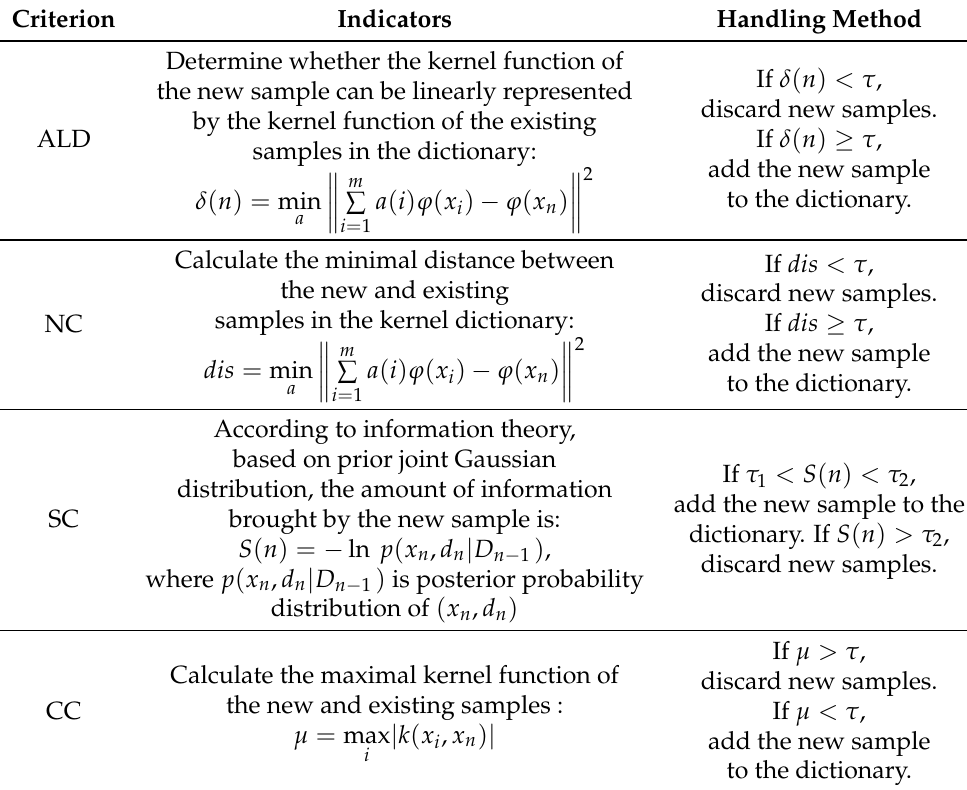
Table 1. Some common sparseness